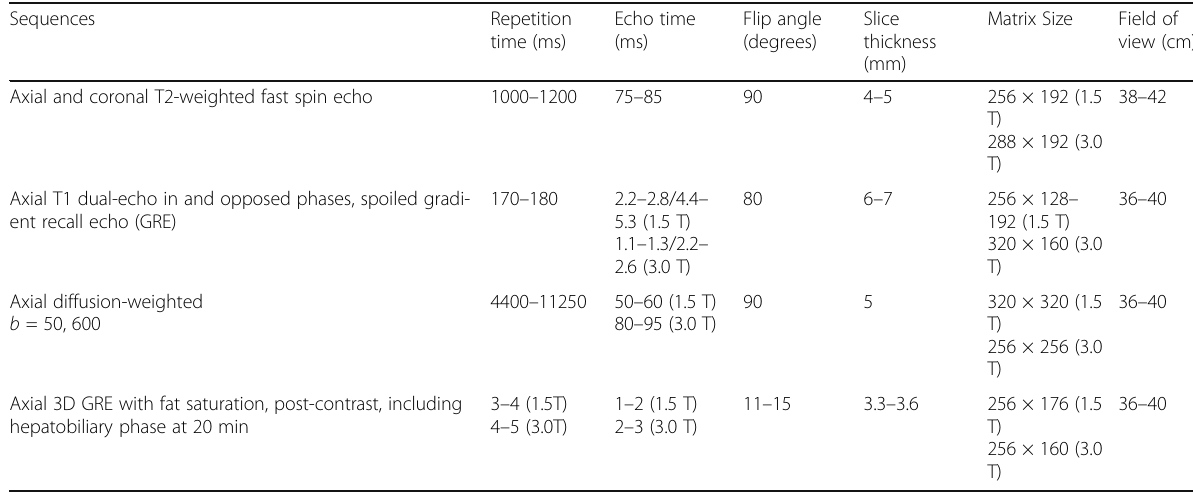
Table 2 Imaging parameters